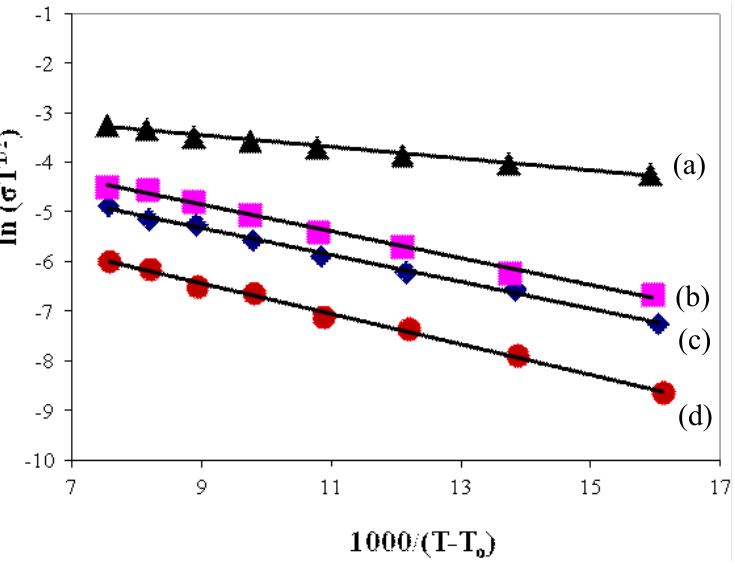
SO CF containing ( a ) 35 wt %; ( b ) 25 wt 4 3 3